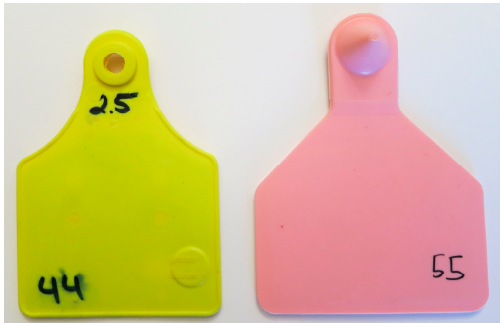
Figure 1. ( left ): ultra-high frequency (UHF) ear tag Type A, ( right ): UHF ear tag Type B.